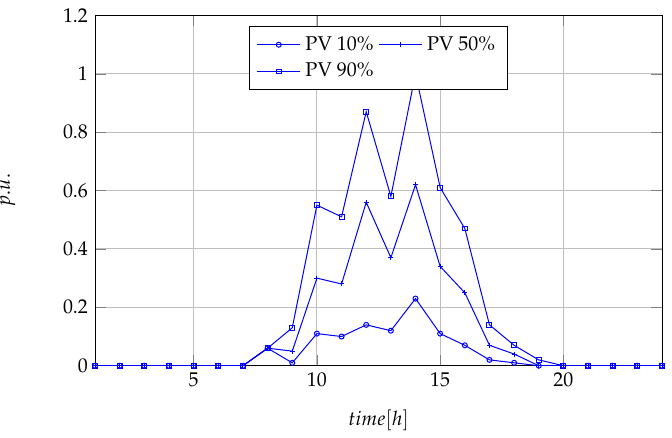
Figure 5. Example of normalized PV probabilistic forecasts.